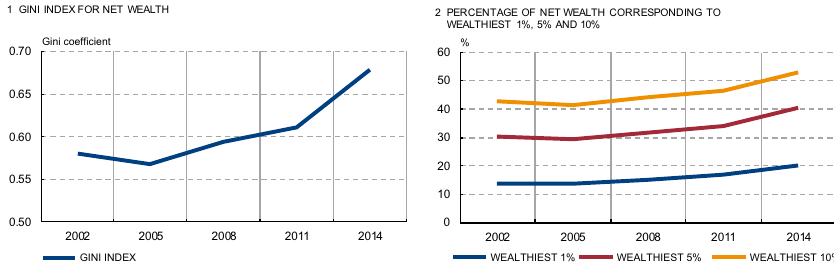
Fig. 14 Wealth inequality indicators. Source : Banco de España